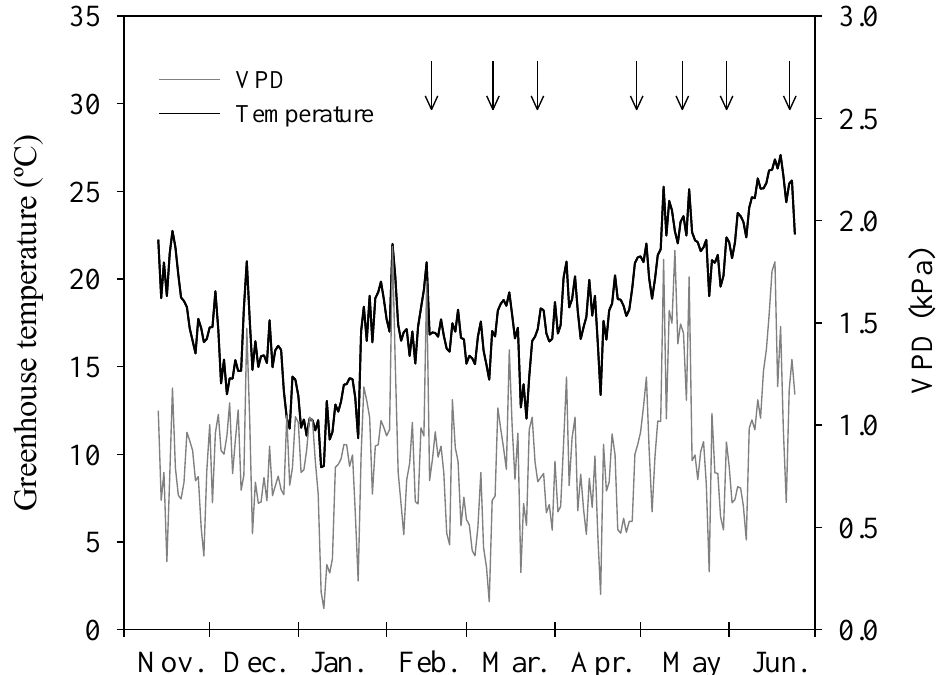
Figure 1. Evolution of daily average temperature and vapor pressure deficit (VPD) during the experimental period (from November 2020 to June 2021). The arrows indicate the days on which physiological parameters were measured.